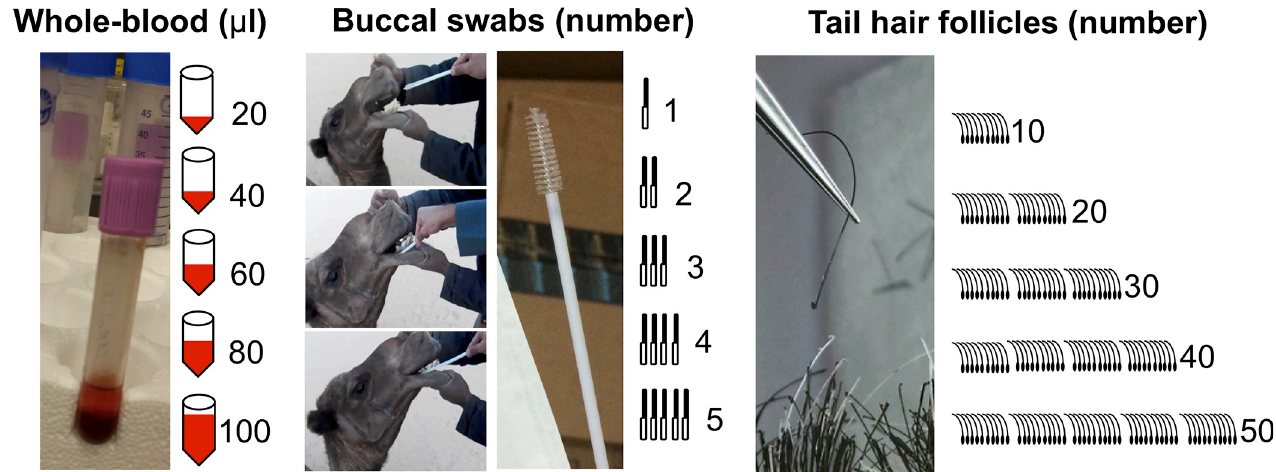
Fig 1. The three sources, and the five quantities, of the camel DNA samples used in the study. DNA extractions were performed on the five different quantities, of each one of the three DNA sources.